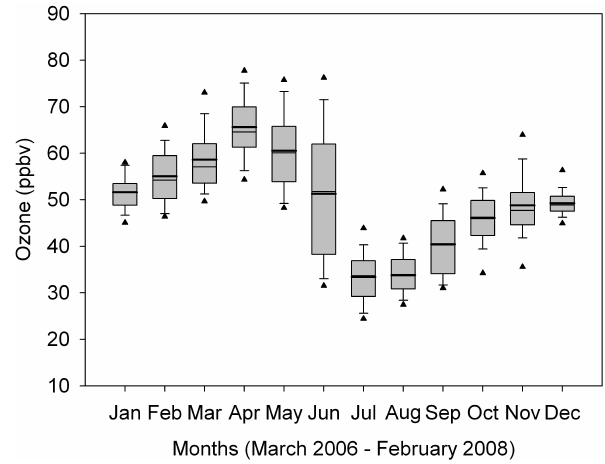
Fig. 3. Box-and-whiskers analysis of daily O 3 means for months from March 2006 to February 2008. The box and whiskers denote the 10th, 25th, 50th, 75th and 90th percentiles, the outliers the 5th and 95th percentiles and the bold lines the average